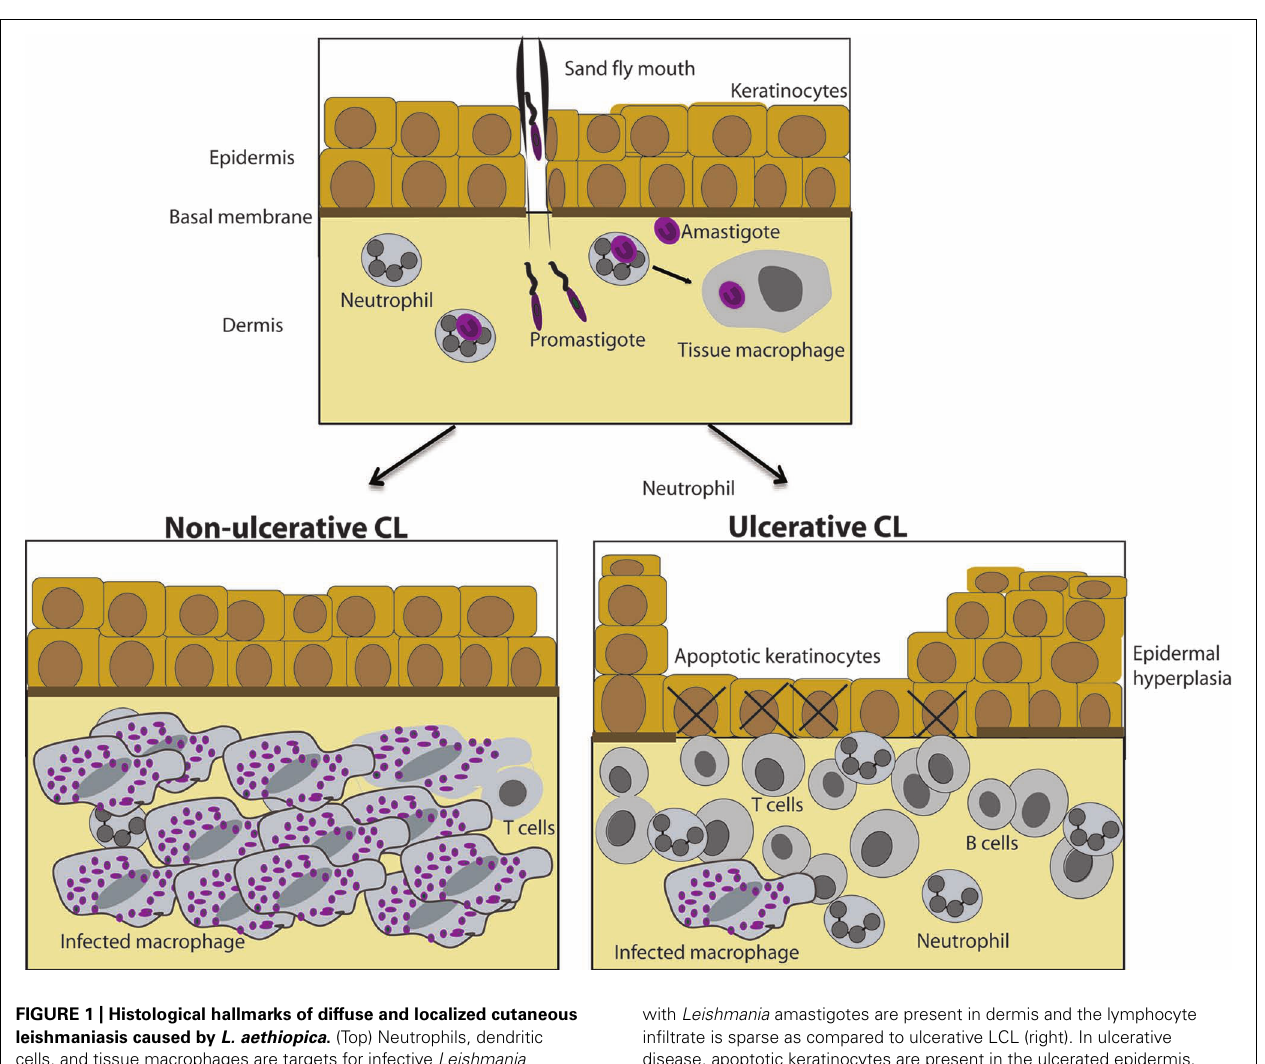
FIGURE 1 | Histological hallmarks of diffuse and localized cutaneous leishmaniasis caused by L. aethiopica . (Top) Neutrophils, dendritic cells, and tissue macrophages are targets for infective Leishmania promastigotes and are present in the healthy skin. (Bottom) L. aethiopica cause non-ulcerative diffuse cutaneous leishmaniasis (DCL) or ulcerative localized cutaneous leishmaniasis (LCL). In non-ulcerative DCL (left), epidermis is intact and a large number of tissue macrophages packed